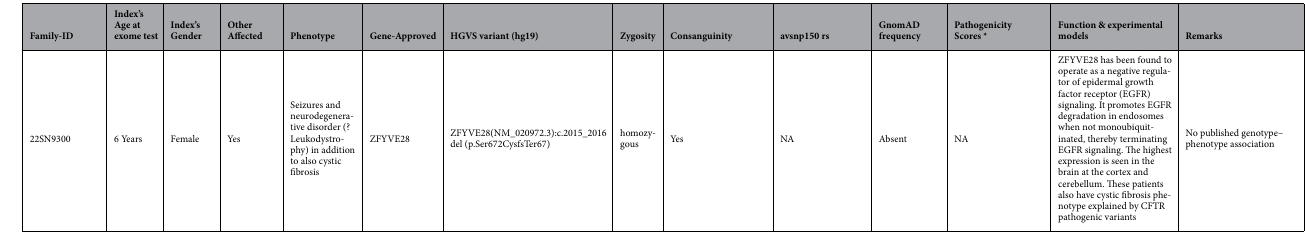
Table 1. Candidate Genes. Several were published previously through gene matching. *MetaLR, MetaSVM, MetaRNN,